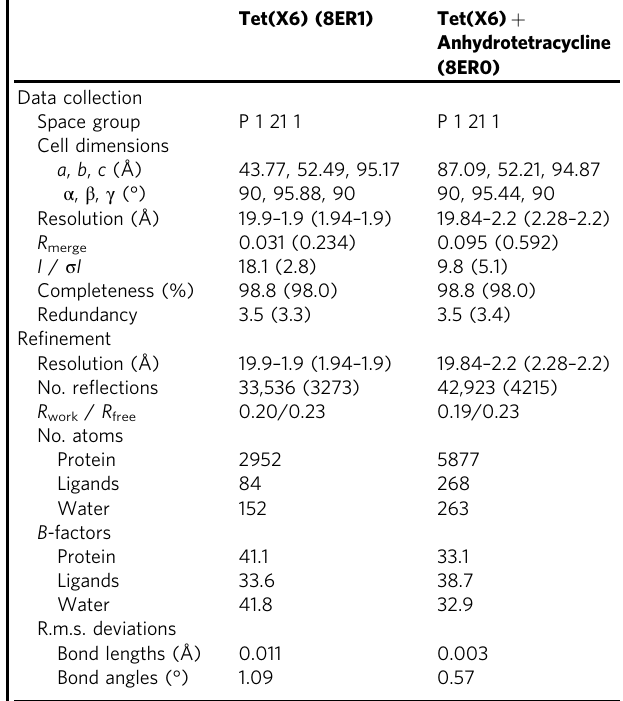
Table 1 Data Reduction Statistics for the Tet(X6) and